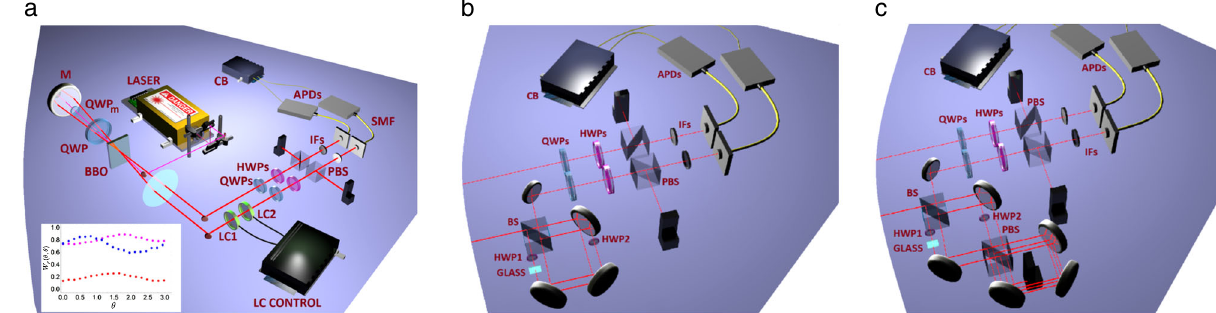
Fig. 1 a Experimental setup for the extractable work-based inseparability of bipartite states: The entangled photon source uses a 1.5-mm thick β Barium-Borate crystal pumped with 100 mW of laser at 355 nm, in conjunction with a spherical mirror (M), and delivers approximately 200 coincidence/s through 5 nm full width at half maximum interference fi lters. Details on the source can be found in ref. 31. We encode the logical states of each qubit in the horizontal and vertical polarization states | H 〉 and | V 〉 of each photon. Using quantum state tomography, we estimate a fi delity F = 0.961 ± 0.007 of the entangled resource with the maximally entangled state 1 ffiffi p ( | HH 〉 + | VV 〉 ). The corresponding value of tangle is T 2 = 0.911 ± 0.008. 34 The relative weight ( cos φ ) of the two polarization contributions in such state can be tuned by the quarter waveplate (Q WP m ) in the source. One of the photons passes through a depolarizing channel, consisting of two LCs and the associated control electronics, which selects the value of μ . Finally, polarization measurements are performed at a polarization-analysis module consisting of a QWP, a HWP, a PBS, and an APD per mode. We also show the single-mode fi bers used to convey the photonics signal to the polarization analysis module. Inset : measured W ρ ( θ , θ ) as a function of the measurement angle θ for state | ρ 〉 with cos φ ¼ 0 : 85 , and μ = 0.98 ( blue ); cos φ ¼ 0 : 62 , and μ = 0.98 ( purple ); cos φ ¼ 0 : 62 , and μ = 0.51 ( red ). b Experimental setup for a GHZ-Cluster state. c Analogous setup for a W -type